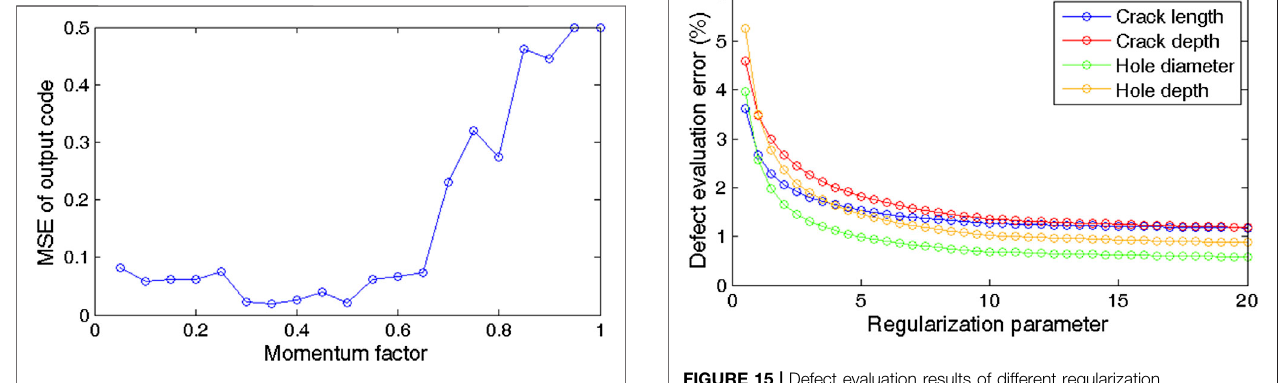
FIGURE 14 | MSE curves of different numbers of momentum factor.